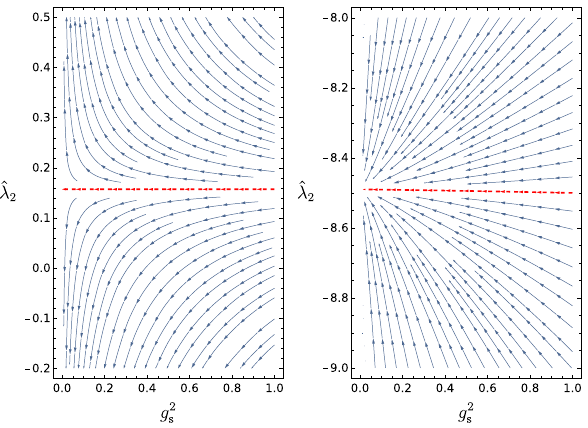
Fig. 2 The one-loop RG flow of the perturbatively renormalizable model projected on the plane of the rescaled Higgs quartic coupling ˆ λ = 1 / 2 as defined in Eq. (11)) and the strong gauge coupling 2 (for P g 2 s . The color and flavor numbers are fixed to N c = 3 and N f = 6. The UV repulsive QFP ˆ λ + in the left panel and the UV attractive QFP ˆ λ − 2 in the right panel are highlighted by red dashed lines that correspond to the solutions in Eq.